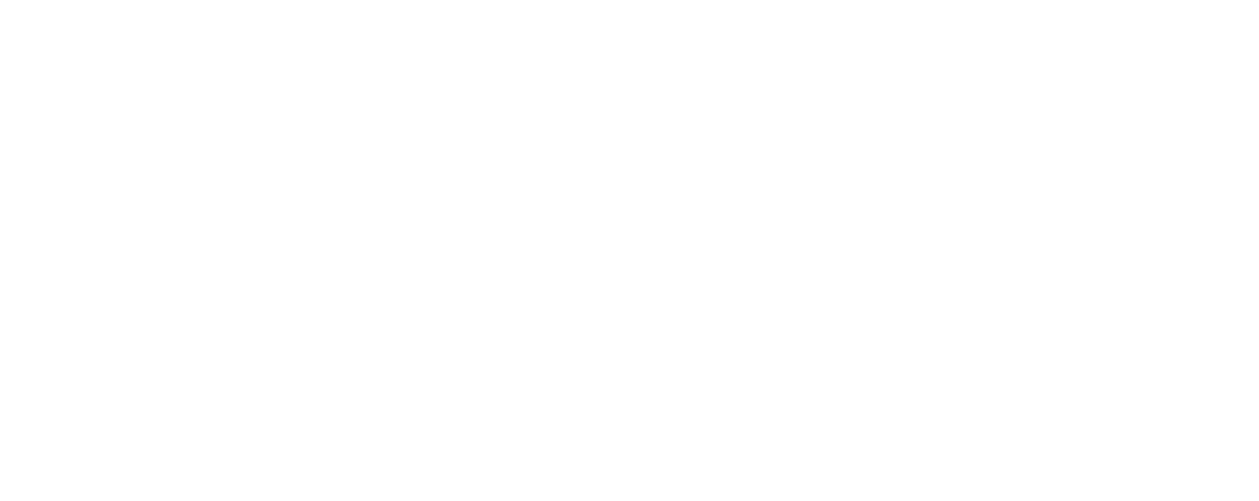
FIGUREA1 | Circular Bayesian Inference tree with sequence names shown (Same tree as Figure 1B). Posterior probabilities for deeply branching nodes are